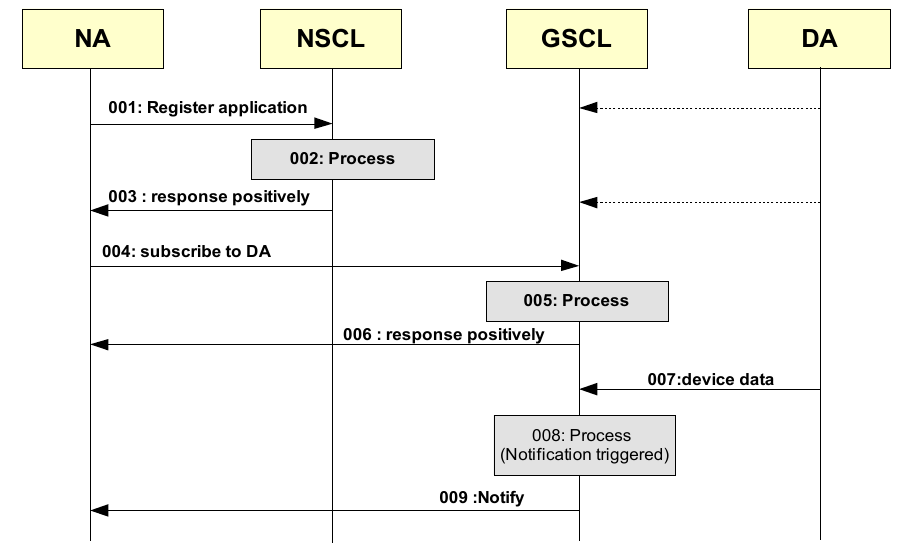
Figure 8. Sequence diagram for a network application subscription to device